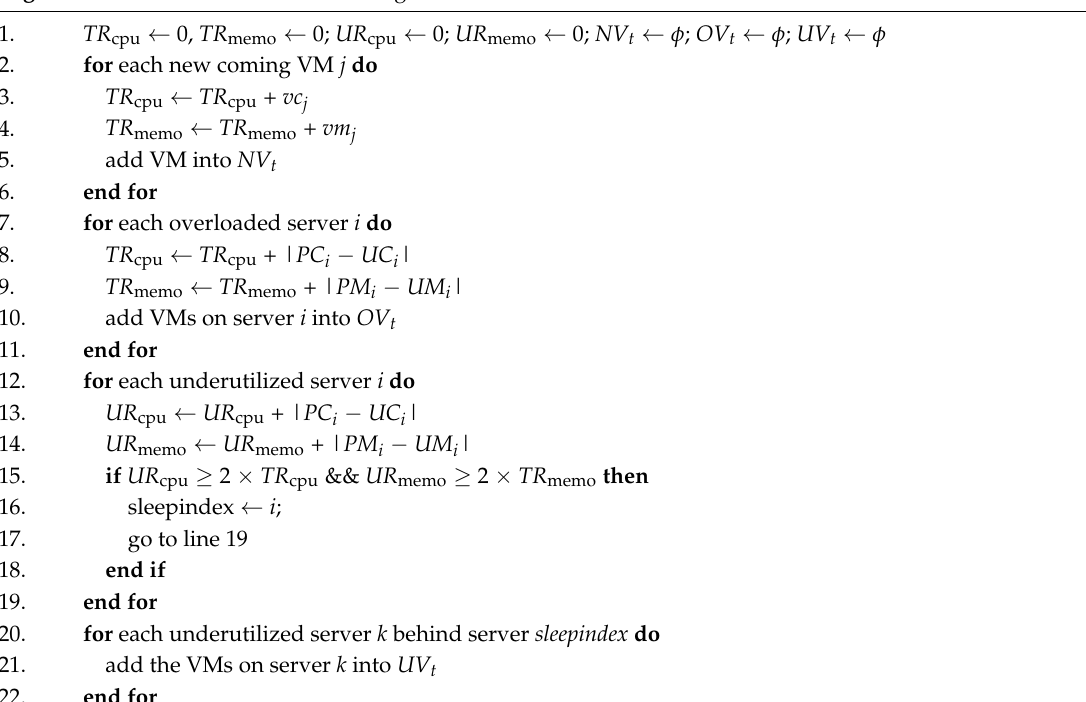
Algorithm 1. Construct VMs set for